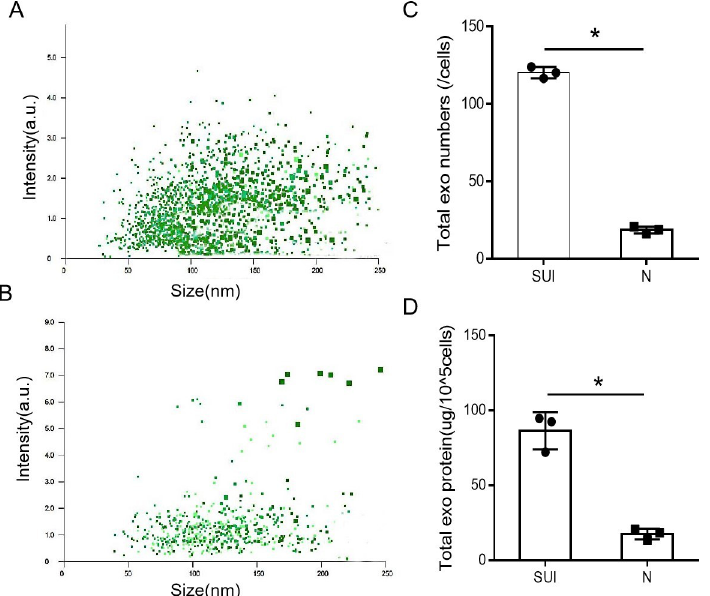
Fig 1. The fibroblast-sEVs from patients with SUI was elevated. (A and B) Scatter plot distribution of SUI-sEVs and non SUI-sEVs with Nanoparticle tracking analysis measurements. (C) Quantitative comparison results of the number of sEVs in the SUI and non-SUI groups. (D) Semi-quantitative comparison results of total protein content of sEVs in the SUI and non-SUI groups. N: non-SUI group, SUI: SUI group, N = 3 in each group. Data represented means ± SD of 3 independent experiments. � t-test P value < 0.05.